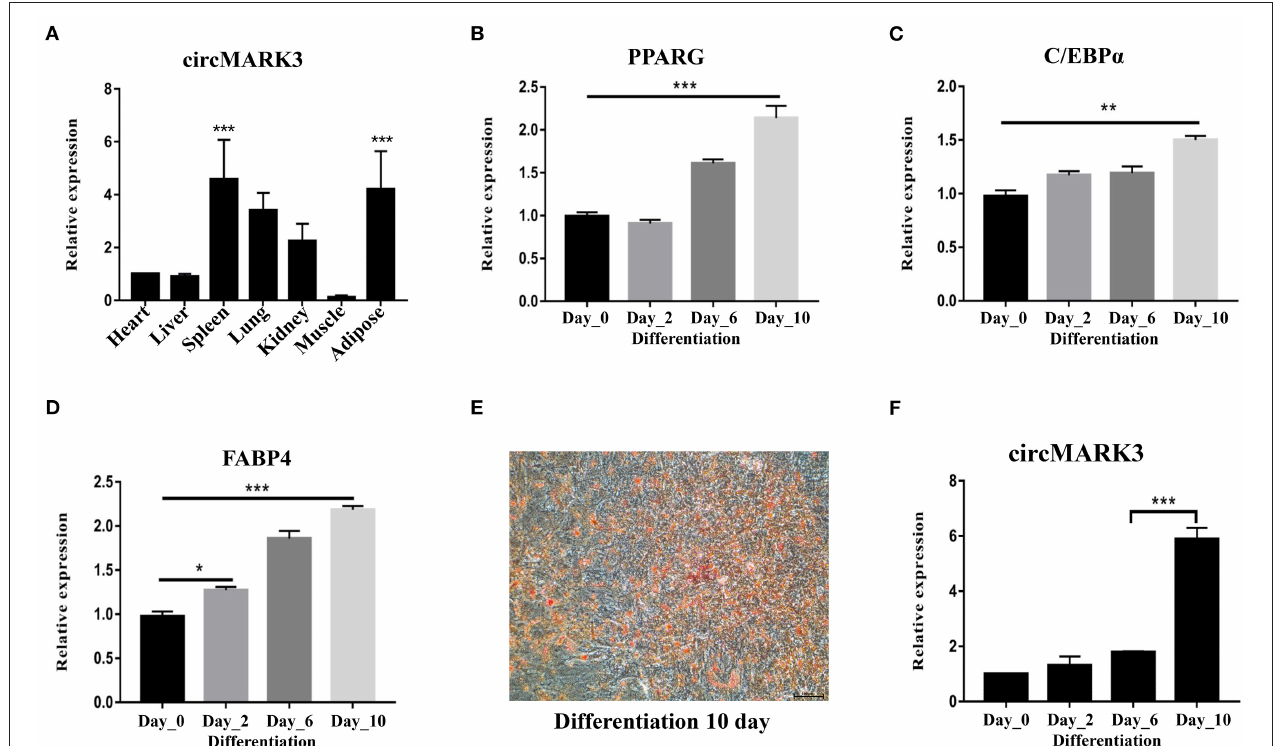
FIGURE 3 | Expression pattern of circMARK3 in tissues and adipocytes of buffalo. (A) Expression profile of circMARK3 in heart, liver, spleen, lung, kidney, muscle and adipose tissues of buffalo; (B–D) expression pattern during buffalo adipocyte differentiation of PPARG (after 0, 2, 6, and 10 days) (B) , C/EBP α (C) and FABP 4 (D) ; (E) Oil Red O staining for detection of buffalo adipocyte lipid deposition (differentiation day 10); (F) Expression pattern of circMARK3 during buffalo adipocyte differentiation. In (A–D) and (F) , bovine- GAPDH was used to normalize the expression level of the reference gene. In panel (A) , data was normalized to the heart. In panels (B–D) and (F) , all data were normalized to day 0. Data are presented as the mean ± SD, n = 3, #:no significance, * P < 0.05, ** P < 0.01, *** P <